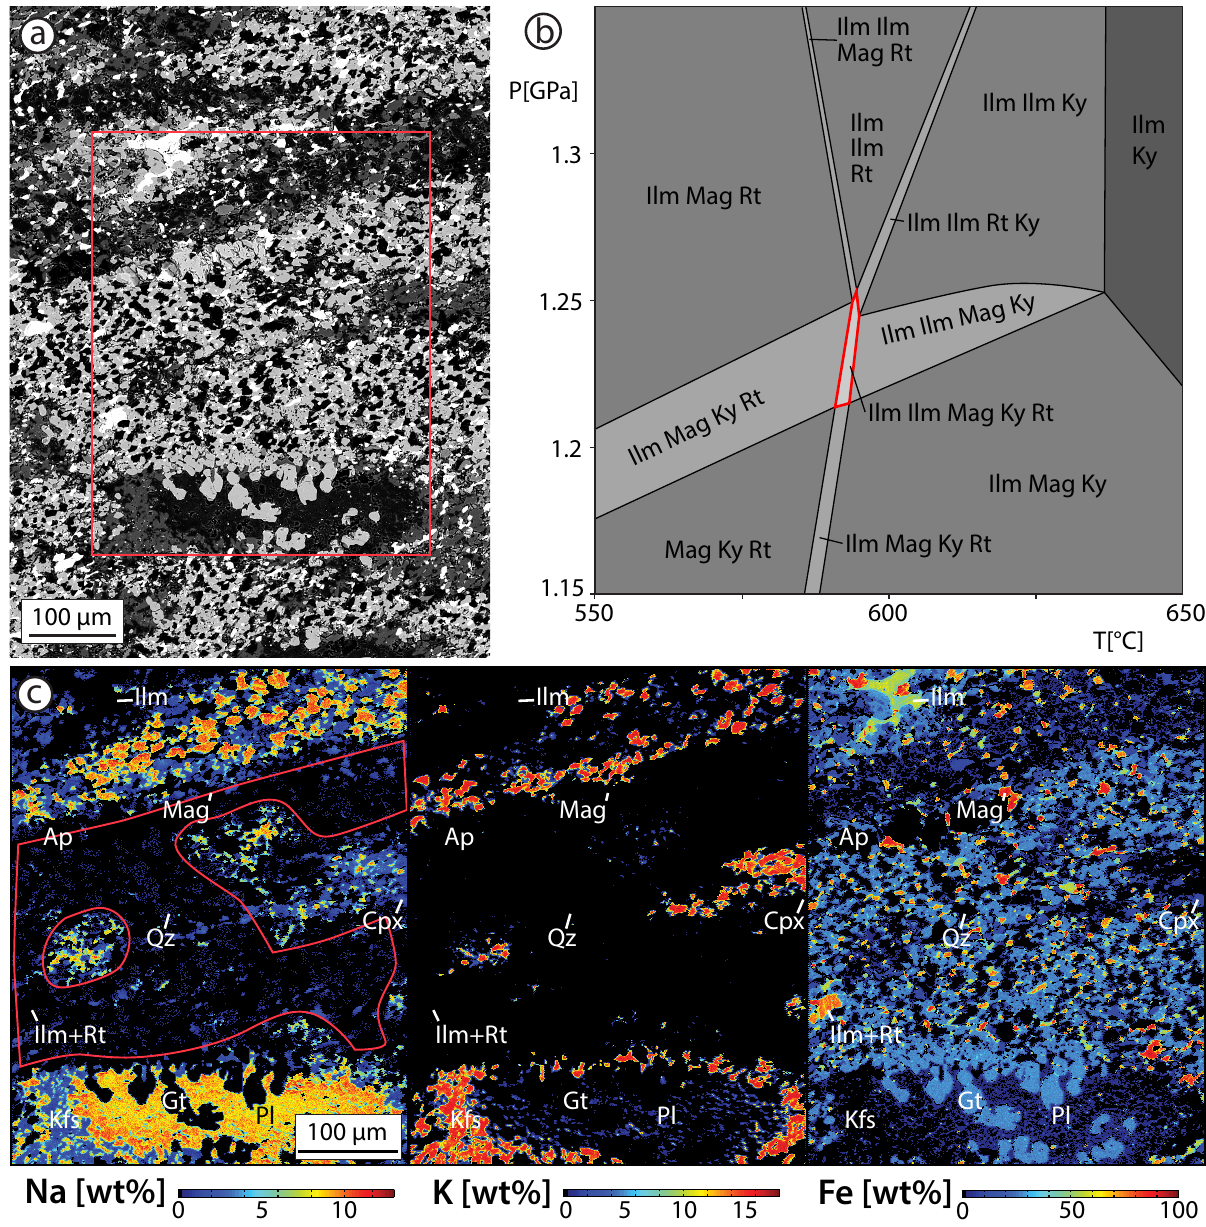
Figure 9. (a) BSE image of a sheared pseudotachylyte with partly recrystallized clasts. The red box indicates the location of the X-ray map. (b) Results from thermodynamic modelling using Perple_X with an estimate for the conditions of shearing at about 1.23GPa and 590 ◦ C. Minerals stable in all fields: Grt, Cpx, Kfs, Qz. (c) Compilation of X-ray maps: Na map shows the incomplete breakdown of a Pl clast in the bottom of the image and the replacement with Kfs (K map). Red outline shows the extracted area of the bulk composition used. Fe map shows abundant Mag (red) and two distinct Ilm populations (green and